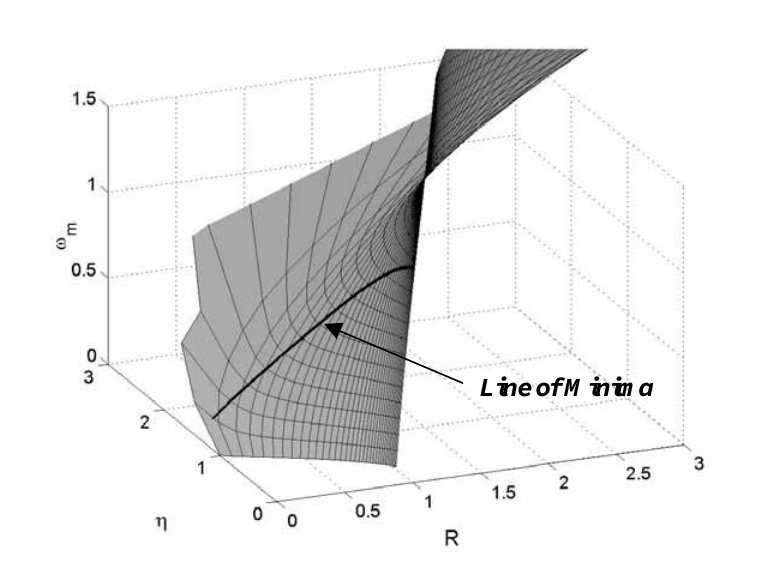
Fig. 22. RMS values of acceleration and relative displacement compared to ω m illustrating the line of